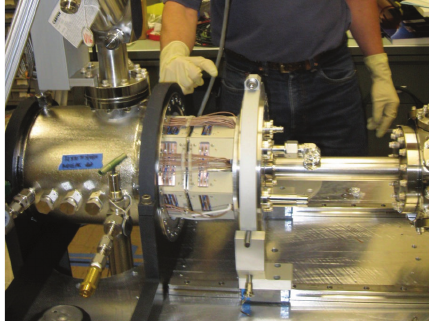
Figure 31: The NEXT-DBDM prototype, operating at LBNL. Inser- tion of the time projection chamber into the stainless-steel pressure